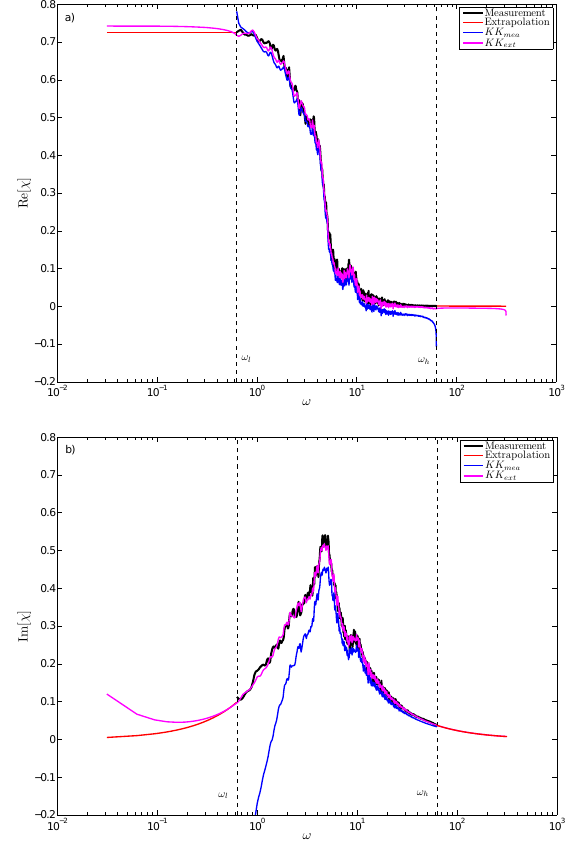
Fig. 6. Linear susceptibility of the energy at the grid point where the local perturbation is applied. The real and the imaginary parts are depicted in (a) and (b) , respectively. The measured and extrapolated values are shown in red and black lines, respectively. The result of the Kramers-Kronig inversion done with the measured and with with the extrapolated data are shown in blue and magenta lines,